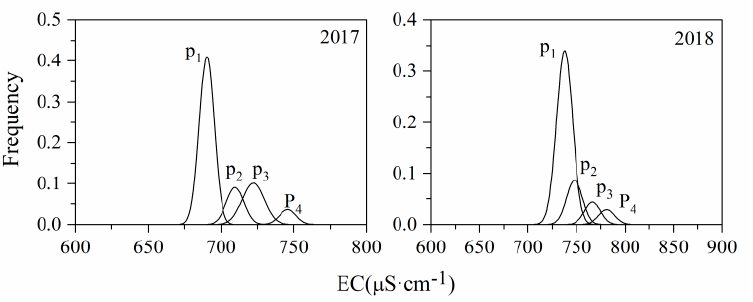
Figure 7. The CFDs of the Tanxi Spring.